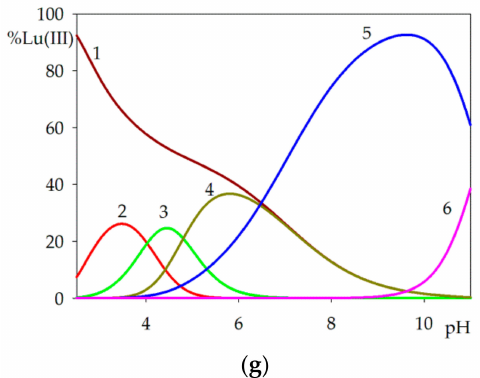
Figure 2. Distribution diagrams for the Ln(III) / Tar systems: ( a ) La(III) / Tar; ( b ) Nd(III) / Tar; ( c ) Eu(III) / Tar; ( d ) Gd(III) / Tar; ( e ) Tb(III) / Tar; ( f ) Ho(III) / Tar; ( g ) Lu(III) / Tar; 1 - Ln 3 + ; 2 – Ln(HTar)(Tar); 3 – Ln(Tar) 2 ; 4 – Ln(Tar) 2 (OH); 5 – Ln(Tar)(OH);6 – Ln(Tar)(OH) 2 ; 7 – Ln(HTar); 8 – Ln(Tar); 9 - Ln(OH) 2 the percentage of the species refers to lanthanide(III) ions; c Ln(III) ion = 1 × 10 -3 mol dm -3 ; c Tar = 1 x 10 -3 mol dm − 3